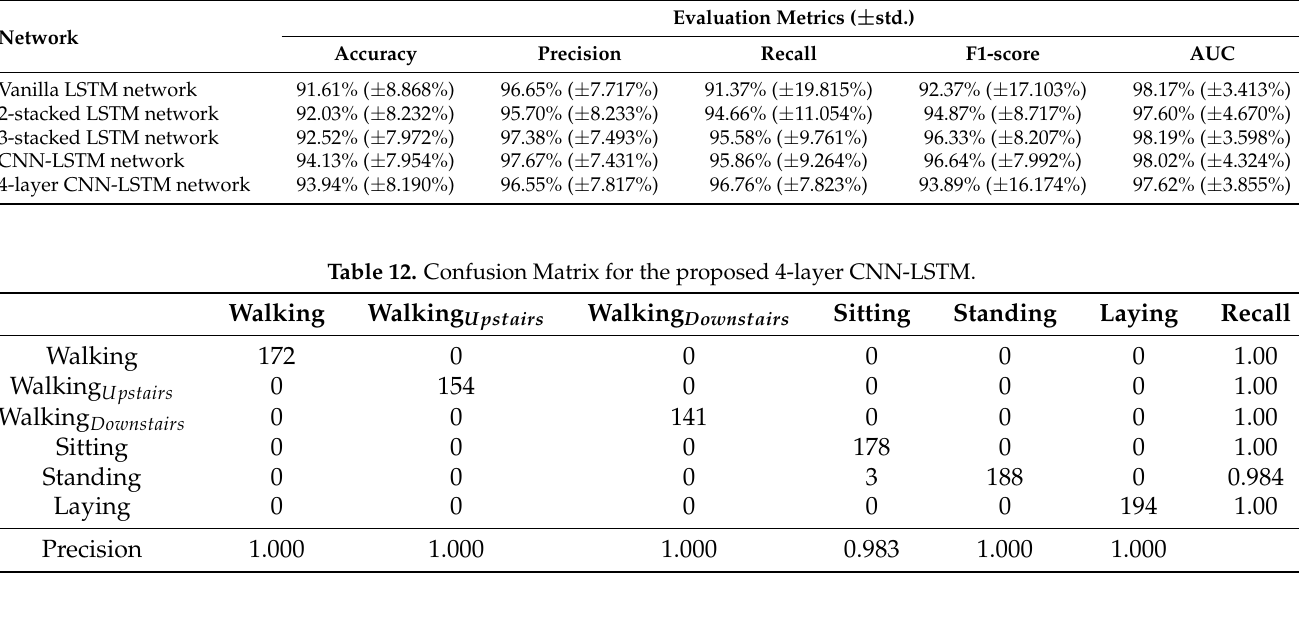
Table 11. Performance metrics of five LSTM networks used in the experiment by NOW sample generation and LOSO cross validation protocol.